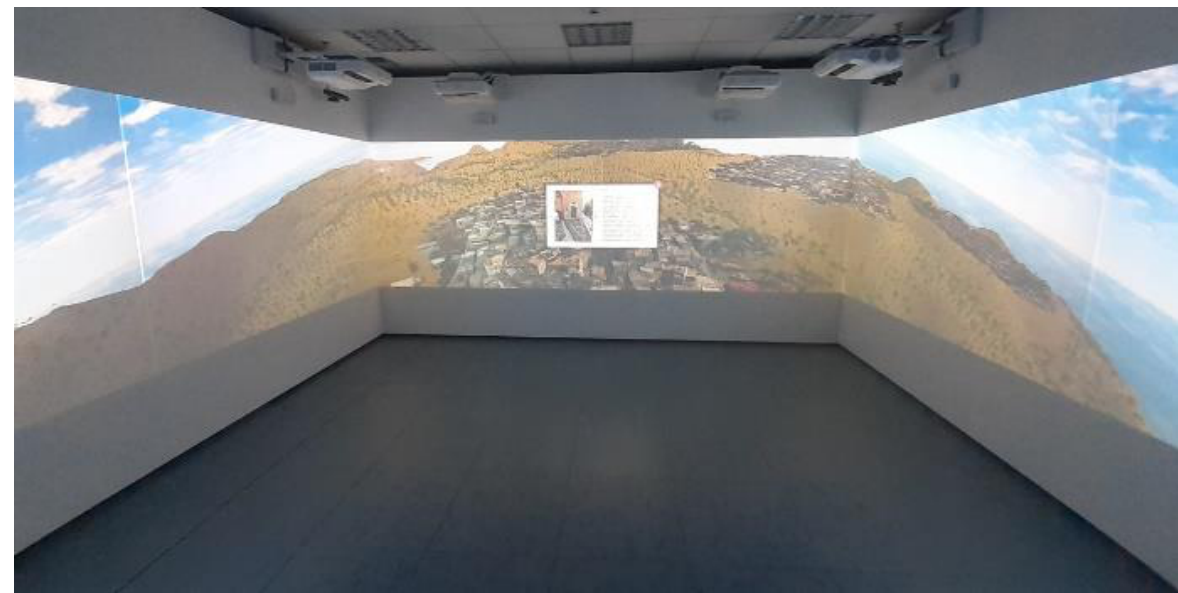
Figure 18. Chios airborne.